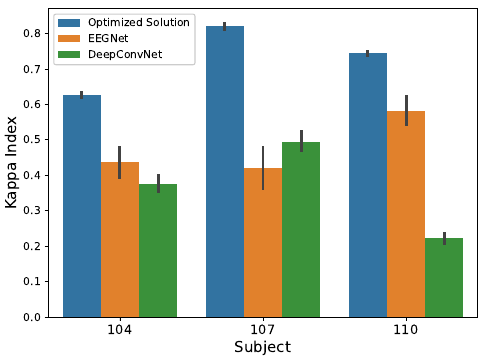
Figure 8. Comparison of the performance that was obtained by different EEGNet models, includ- ing the optimized architecture generated by our optimization framework, corresponding to the Pareto